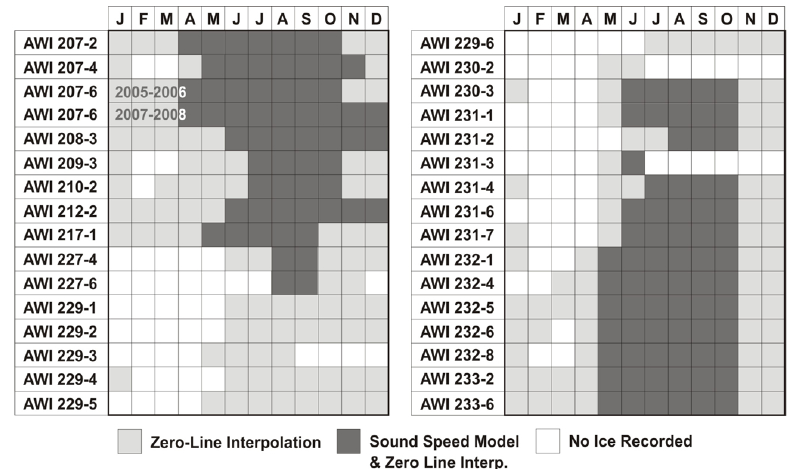
Figure 11. Periods of di ff erent ice draft correction in all available data sets. The winter months (dark colour) were identified by visually checking their draft values for possible leads. The winter months were corrected by the sound speed model and the zero-line interpolation (see text).